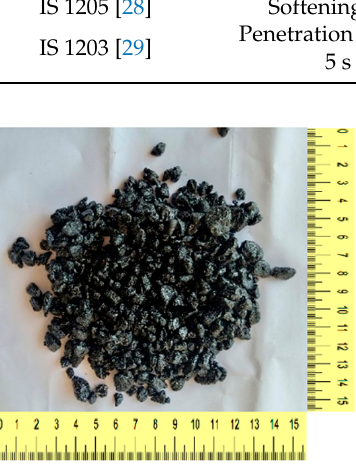
Figure 4. Asphalt-coated aggregates.